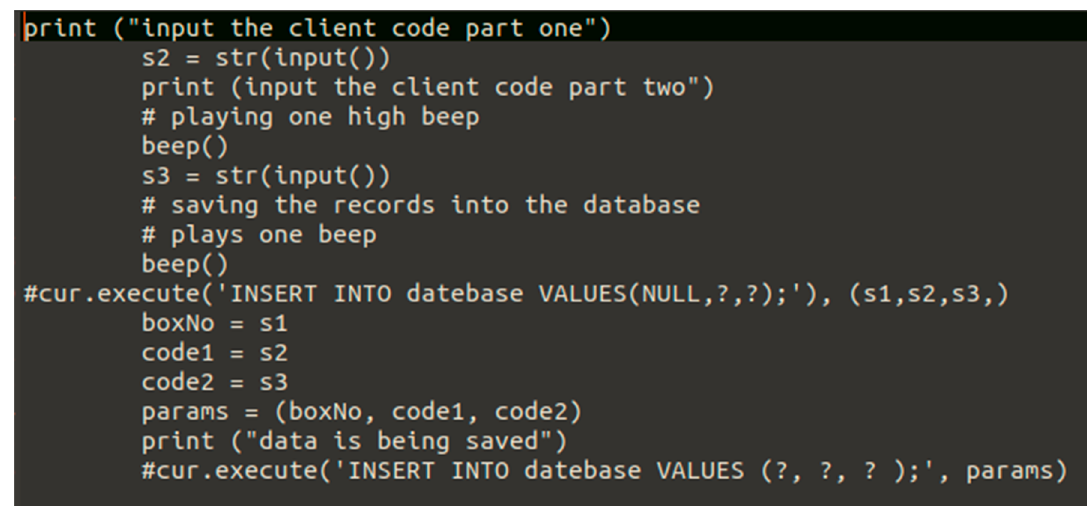
11 of 18 Figure 7. A photograph of Raspberry PI B solution used in the machine.